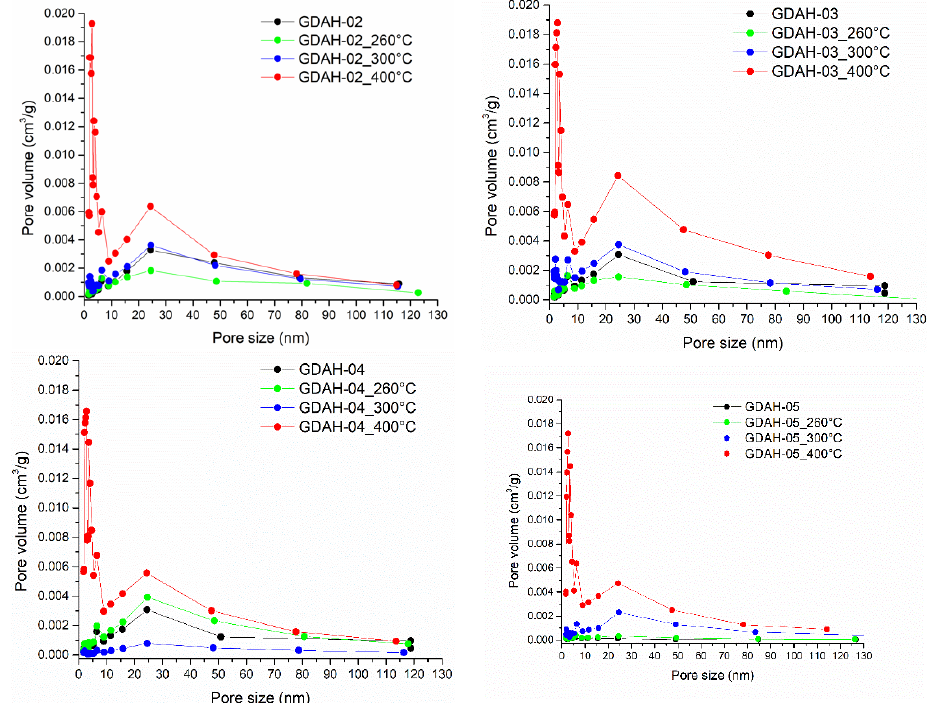
Figure 8. Pore size distribution curves for the initial samples and after thermal treatments at 260, 300, or 400 °C for 2